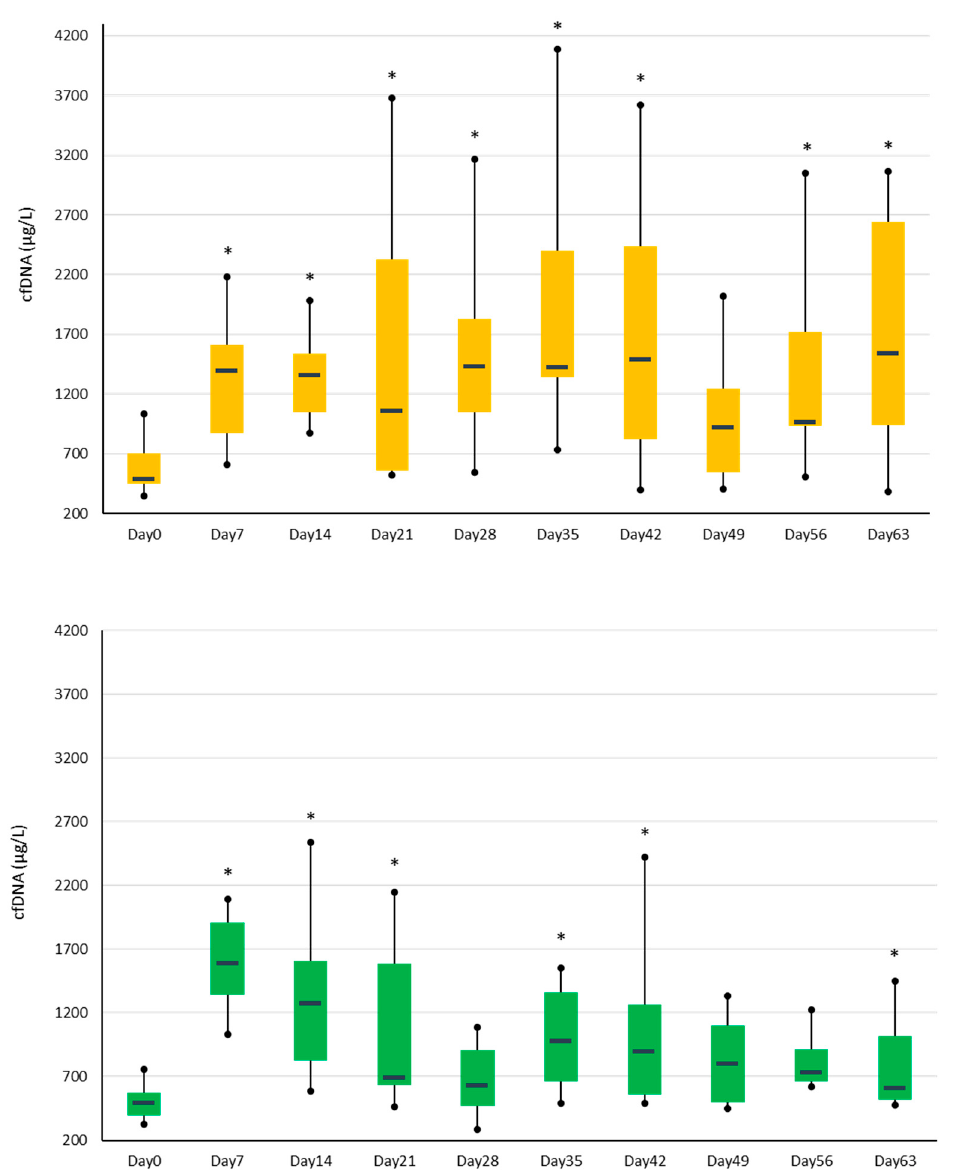
Figure 1. Synovial fluid cell-free DNA concentrations in the OA (top graph) and sham (bottom graph) joints over time. The * indicates significant differences ( p < 0.05) from the respective Day 0 values. The bars represent the interquartile range, and the horizontal lines within the bars are the median values. Whiskers indicate the minimum and maximum values.